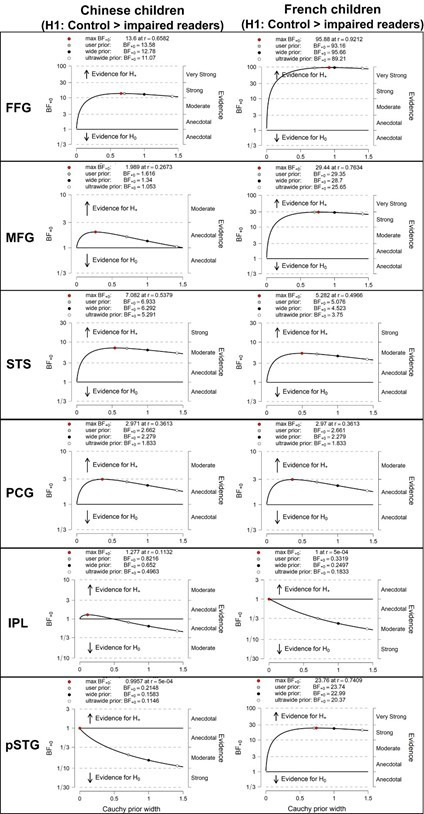
Sensitivity analysis with a variety of priors in the post-hoc pairwise comparisons between controls and impaired-readers in each language (Left: Chinese children; Right: French children).